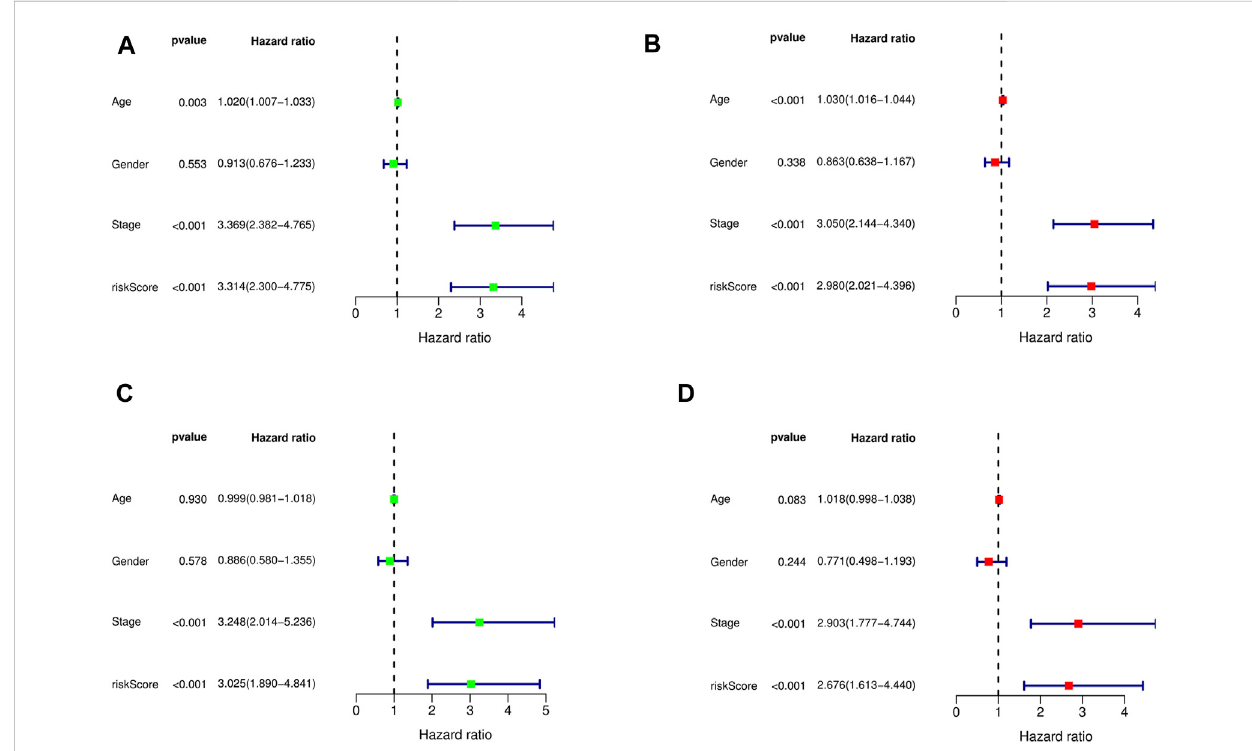
FIGURE 4 Univariate and multivariate Cox regression analysis showed the relationship between age, gender, stage, risk score, and overall survival, and indicated that risk score could be used as an independent prognostic factor for training cohort (A,B) , test cohort (C,D)